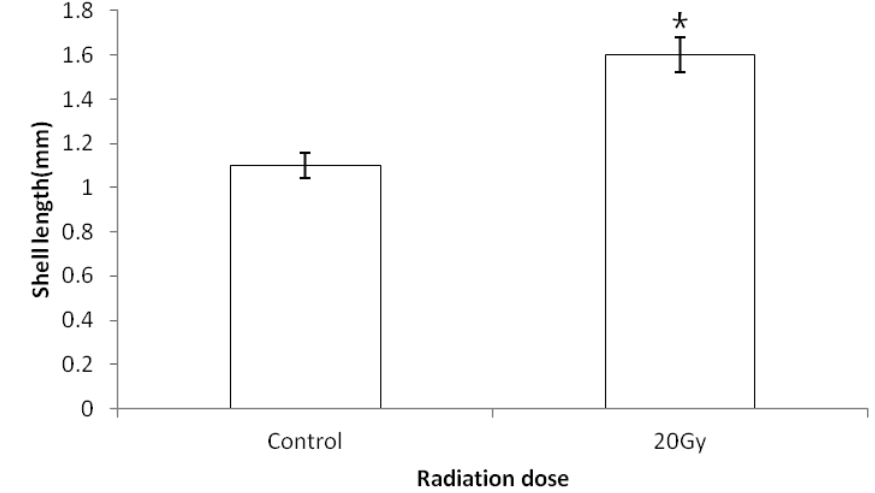
Figure 5. Changes in growth in juvenile Haliotis diversicolor aquatilis for each gamma-ray dose.